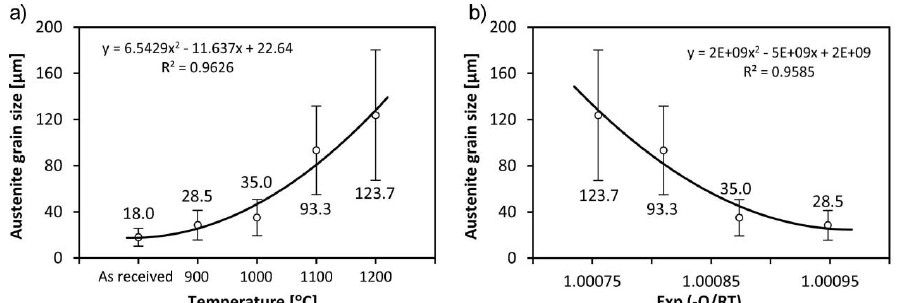
Figure 2. Austenite grain size ( a ) in the as-received state and at different austenitizing temperatures; ( b ) as an Arrhenius plot.